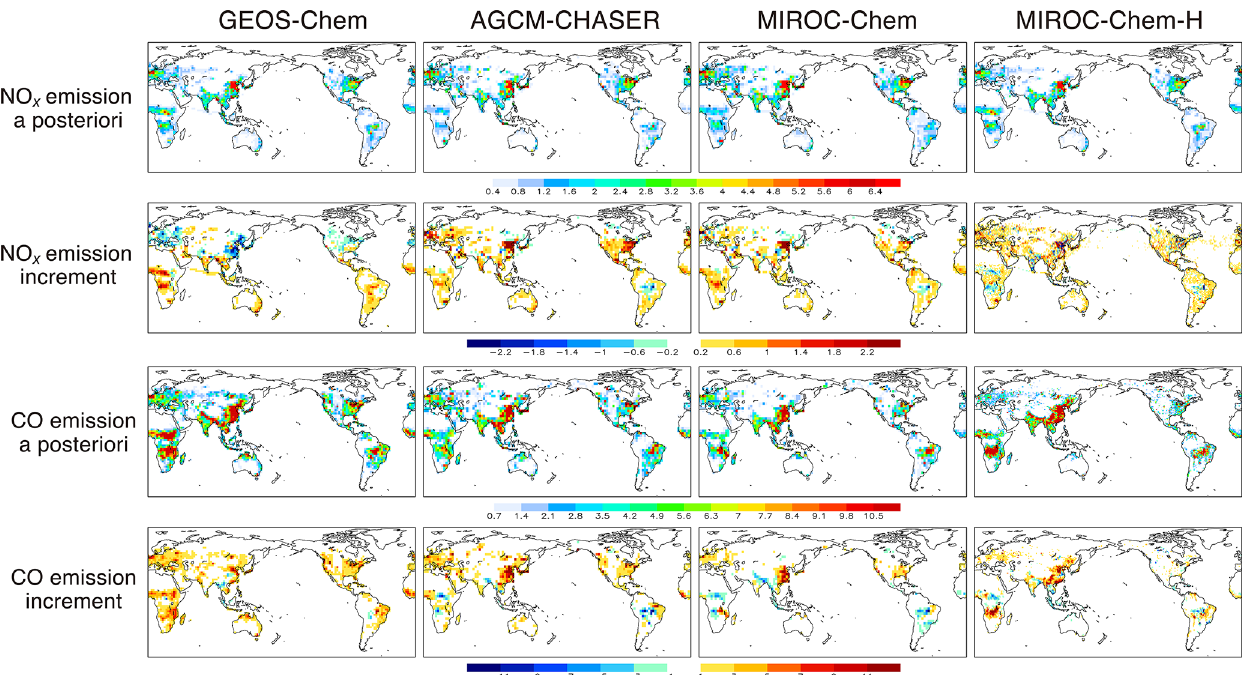
Figure 16. Global distributions of annual mean surface NO x emissions (10 − 11 kgNm − 2 s − 1 ) and surface CO emissions (10 − 10 kgCOm − 2 s − 1 ) for 2007. The a posteriori emissions and analysis increment (a posteriori minus a priori emissions) are shown.